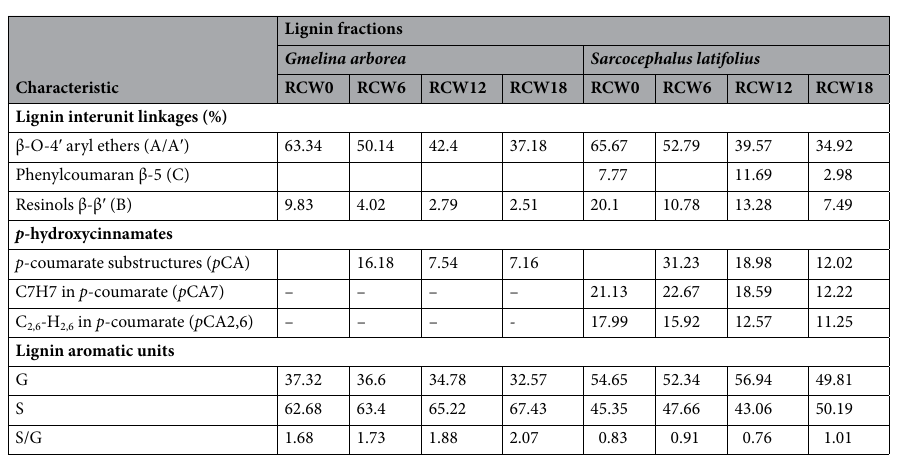
Table 6. Structural characteristics (lignin interunit linkages, cinnamyl end-groups, aromatic units and S/G ratio) obtained from integration of 13 C– 1 H correlation signals in the HSQC Spectra of the lignin isolated from RCW of G. arborea and S.